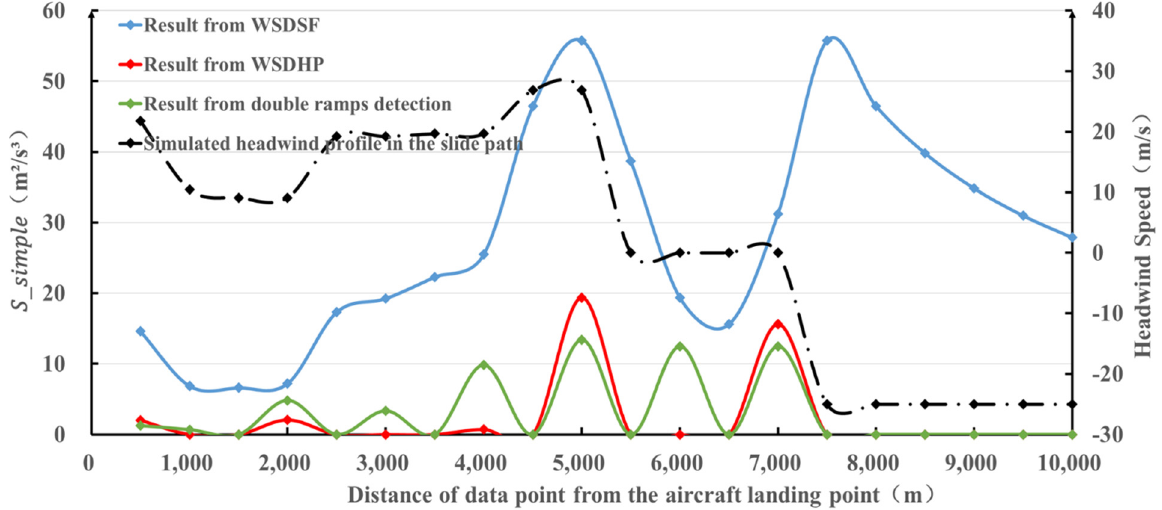
Figure 9. The results of wind shear detection under the background of the downdraft wind field.